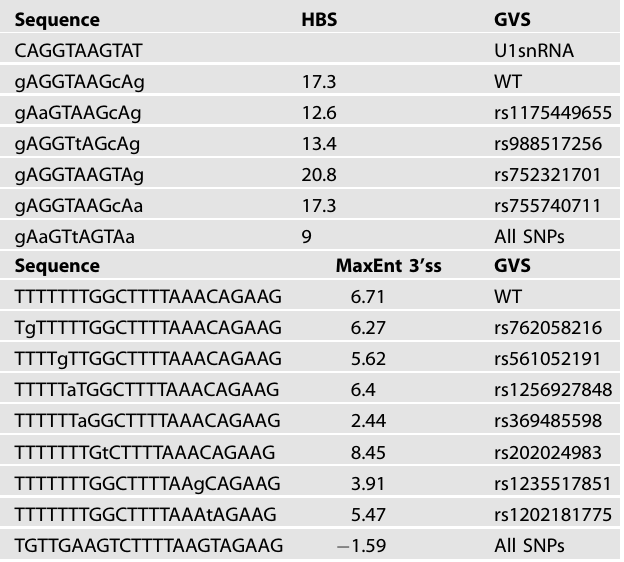
Table 1. The impact of SNPs on the intrinsic strength of WT and MT HMMR exon 4 splice donor and acceptor